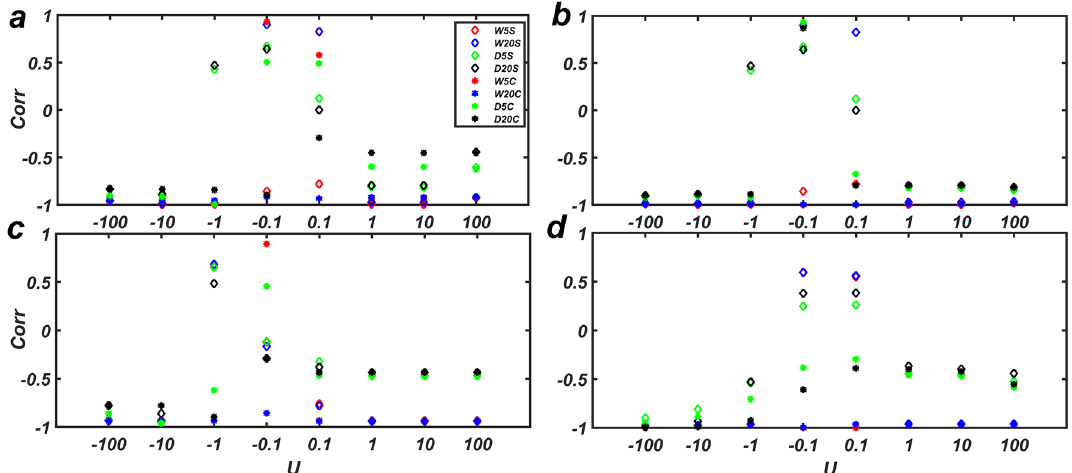
Figure 5. The correlation coefficient between f and g with different input signals in real networks. Designations and settings are as Table